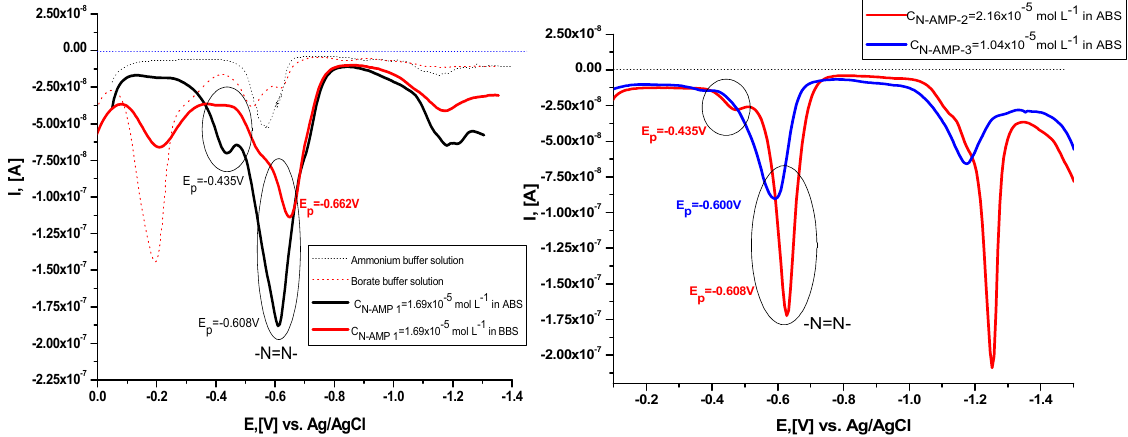
Figure 9. Differential pulse voltamperograms (cathodic) of investigated azo-azomethine derivatives in ammonium (pH 10.35, 0.1 mol L − 1 ) and borate (pH 9.18, 0.1 mol L − 1 ) buffer solutions at HMDE working electrode and Ag/AgCl, KCl (3 mol L − 1 ) as reference electrode.